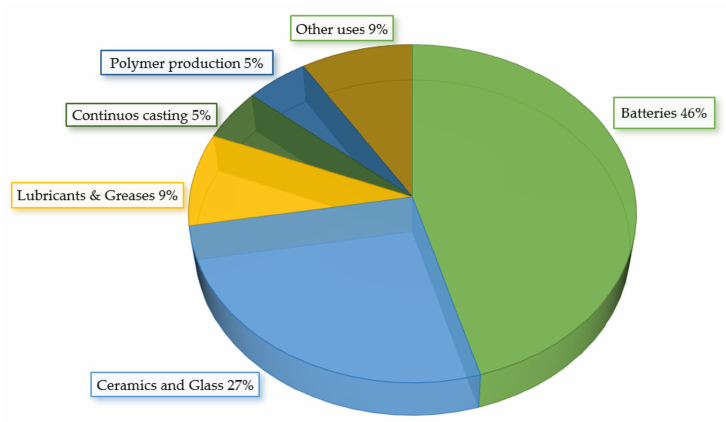
Figure 2. Global lithium end-use market shares